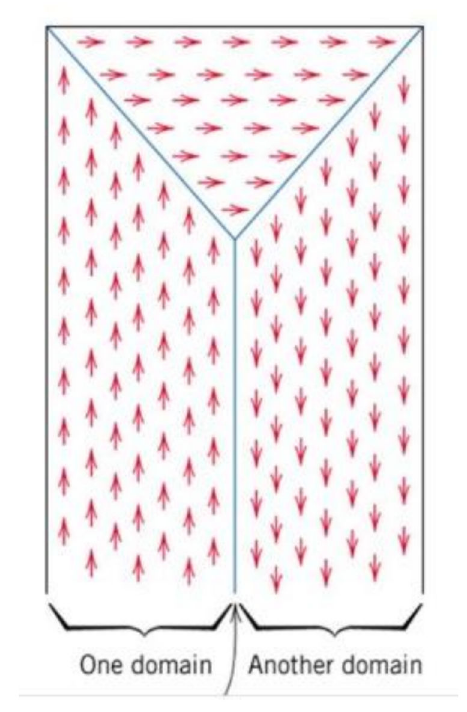
Figure 7. Schematic depiction of domains in a ferromagnetic material